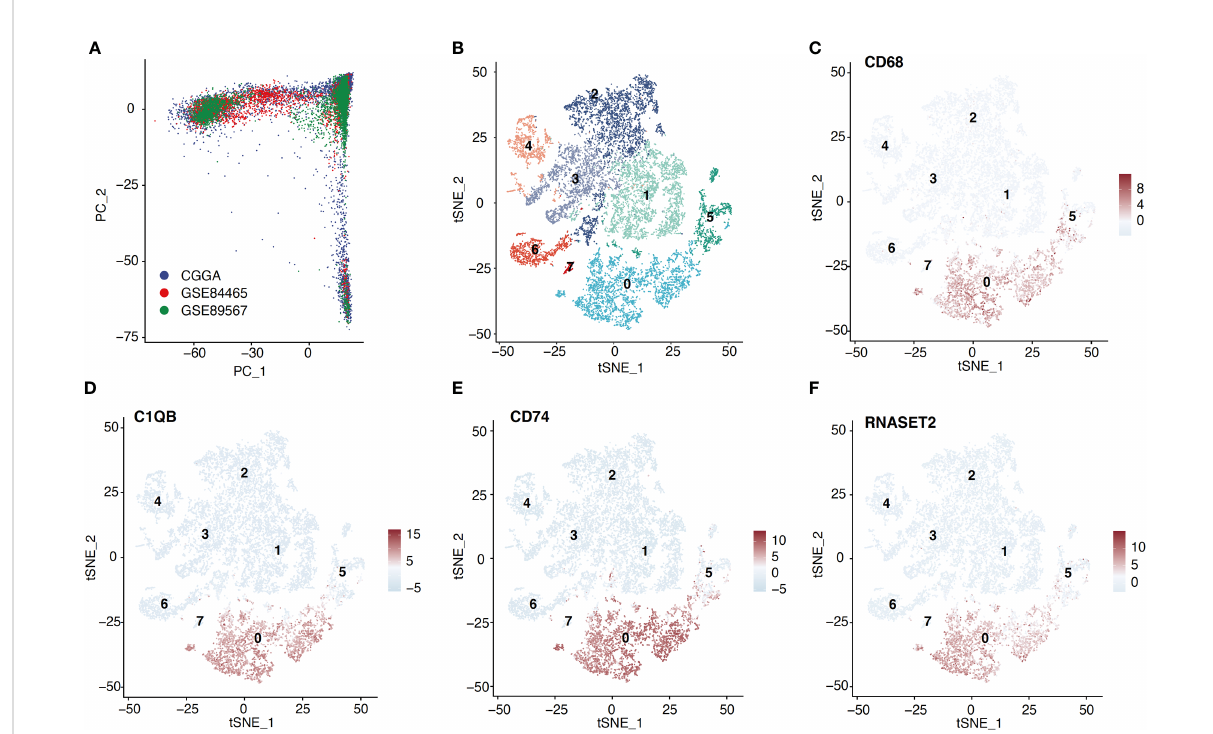
FIGURE 1 Macrophage cluster was identi fi ed based on scRNA-seq data. (A) ScRNA-seq data from three cohorts were shown based on the PCA algorithm. (B) The tSNE algorithm was applied for dimensionality reduction and 8 cell clusters were successfully classi fi ed. (C – F) tSNE plots show the marker genes expression for